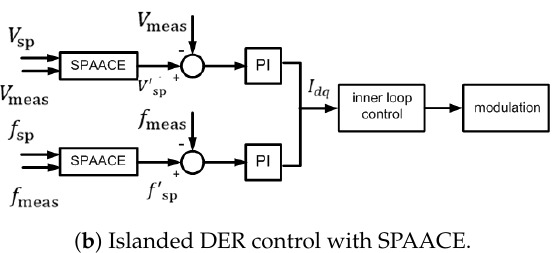
Figure 4. SPAACE incorporation within the DER